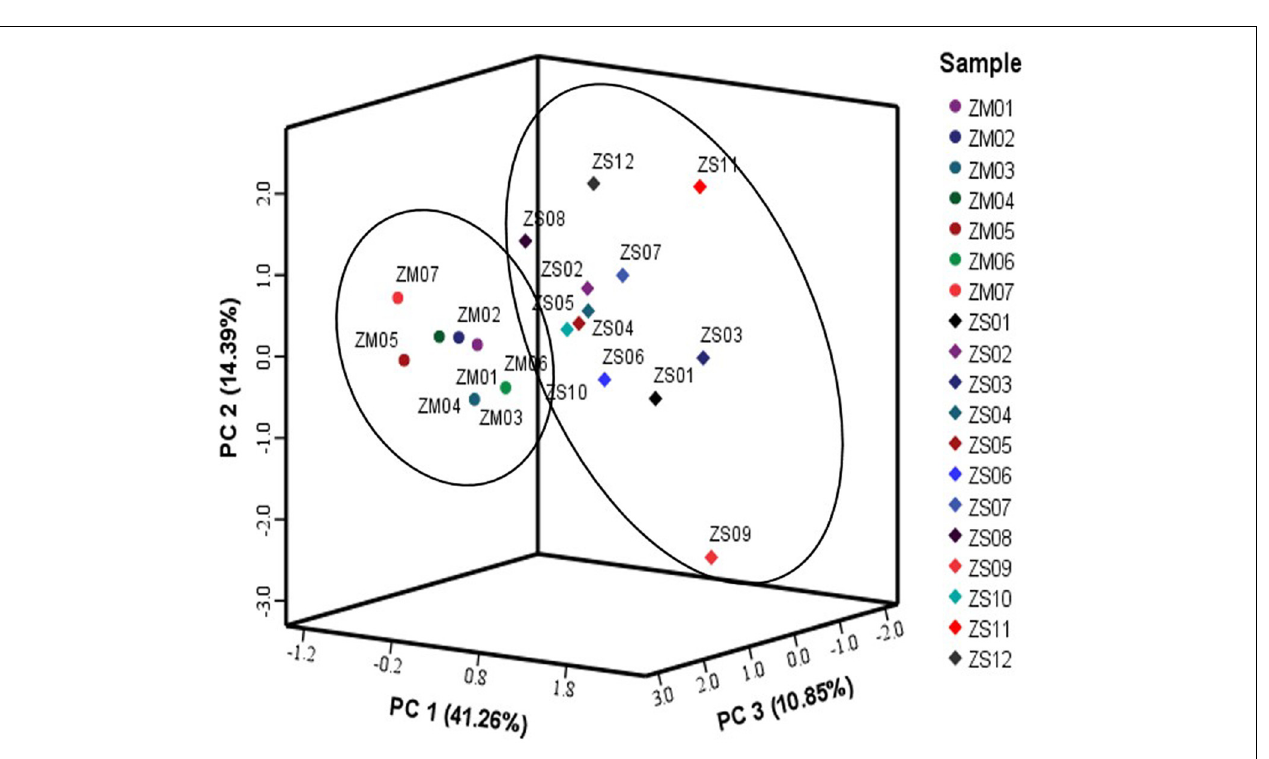
) and Z. mauritiana (ZM, (cid:7) (cid:32)